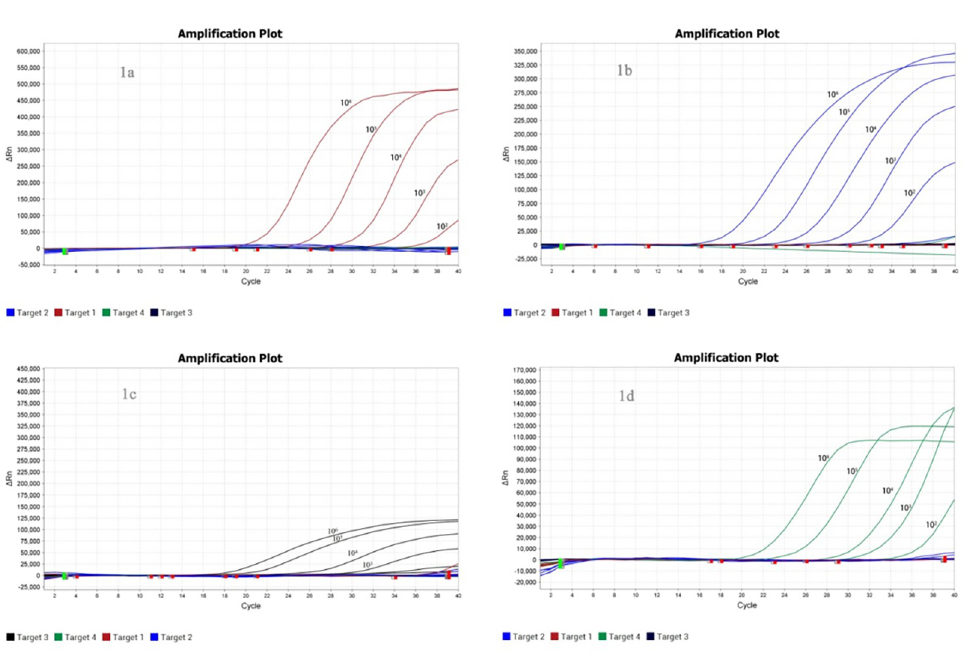
and aMPV-C positive samples also tested positive in the quadruple real-time RT-PCR assay, but they tested negative to the probes for aMPV-A and aMPV-D. Thus, the quadruple real- time RT-PCR assay demonstrated high specificity for the detection of all subgroups of aMPV (Fig 2). Evaluation of the real-time RT-PCR assay using avian clinical samples The real-time RT-PCR assay detected 39 positive samples out of 1920, in agreement with the results of the RT-PCR assay. The sensitivity of the RT-PCR was tested by the four standard plasmids. The κ value for RT-PCR and real-time RT-PCR was 1.000 ( P < 0.001) (Table 4). Epidemiological analysis of aMPV Out of 1920 avian clinical samples, 39 (2.03%) were positive. The geography and host distribu- tion of the 39 positive samples were analyzed. Whenever one or more sample from a live